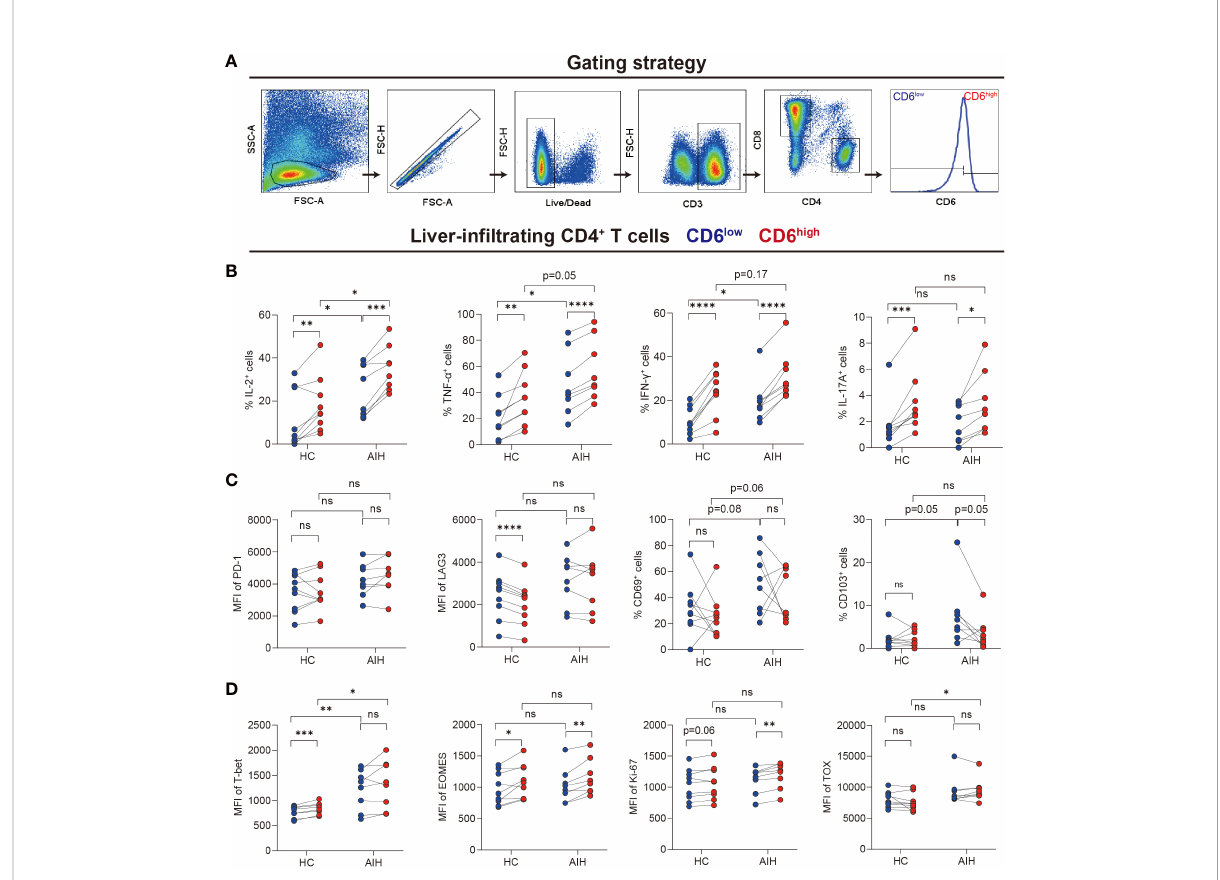
FIGURE 3 Intrahepatic CD6 high CD4 + T cells demonstrated proin fl ammatory functions. Paired CD6 high and CD6 low cells among CD4 + T cells of liver- in fi ltrating cells from healthy donors (n=9) and patients with AIH (n=8) were analyzed by fl ow cytometry. (A) The gating strategy for grouping intrahepatic CD4 + T cells into CD6 high and CD6 low subsets. (B – D) The expression of intracellular cytokines, surface markers, and transcription factors on CD6 high and CD6 low subsets from the liver of HC (n=9) and AIH (n=8). *p < 0.05, **p < 0.01, ***p < 0.001, ****p < 0.0001, ns: not signi fi